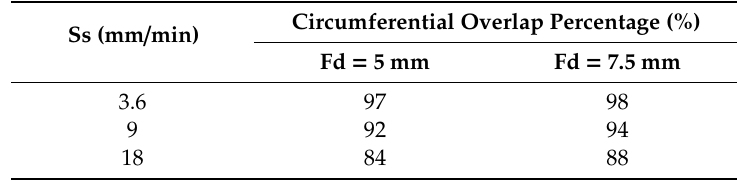
Table 6. Circumferential overlap percentage (COP) at di ff erent scan speed and focal distance.